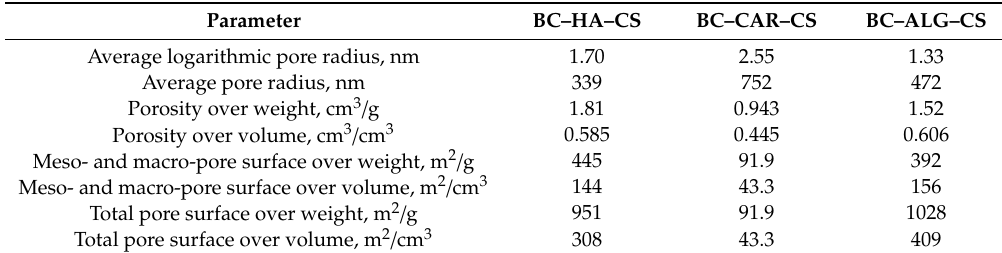
Table 3. The porosity of bacterial cellulose composites.